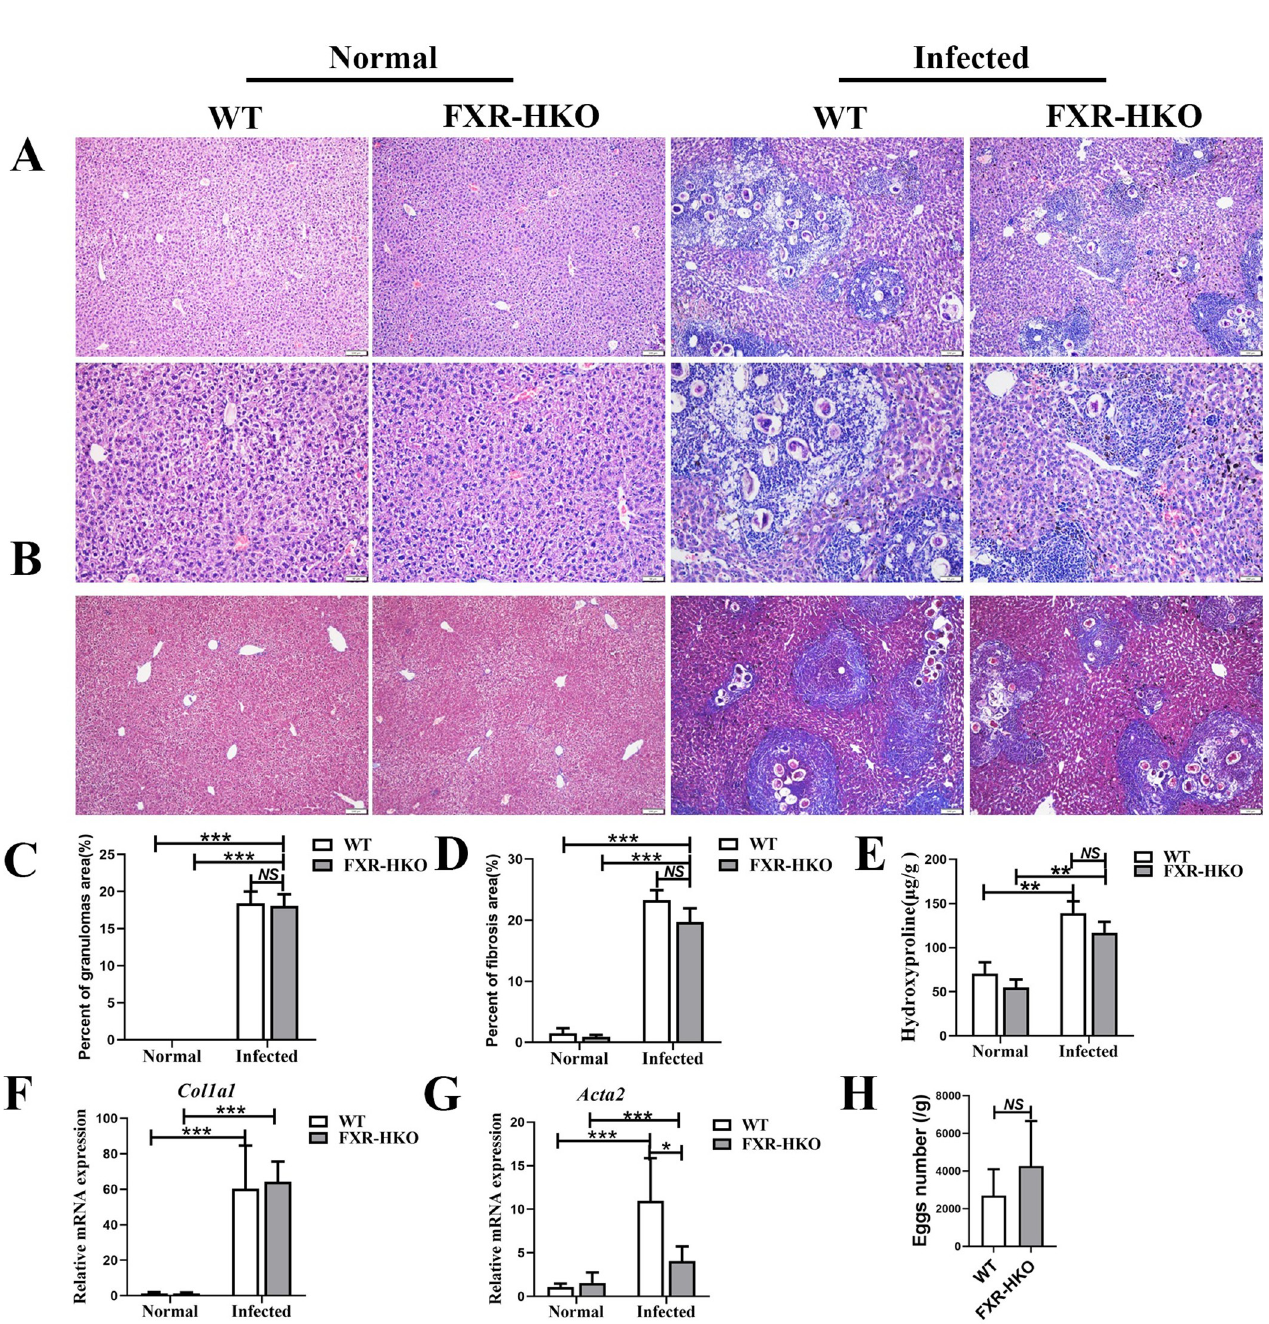
Fig 3. FXR deficiency does not affect hepatic granulomas and fibrosis caused by S . japonicum infection for 5 weeks post-infection. (A) Representative images of HE staining for each group. (B) Representative images of Masson staining for each group. (C) Percent of granulomas area was analyzed according to HE staining by Image Pro Plus 6.0 software. (D) Percent of fibrosis area was analyzed according to Masson staining by Image Pro Plus 6.0 software. (E) Liver hydroxyproline was detected by the alkaline lysis assay. The expression of Col1a1 (F) and Acta2 (for encoding protein α -SMA) (G) in liver were detected by RT-qPCR. (H) Eggs per gram in mice liver infected with S . japonicum . Data are presented as mean ± SEM. NS means no significance, � P < 0.05, �� P < 0.01, ��� P <